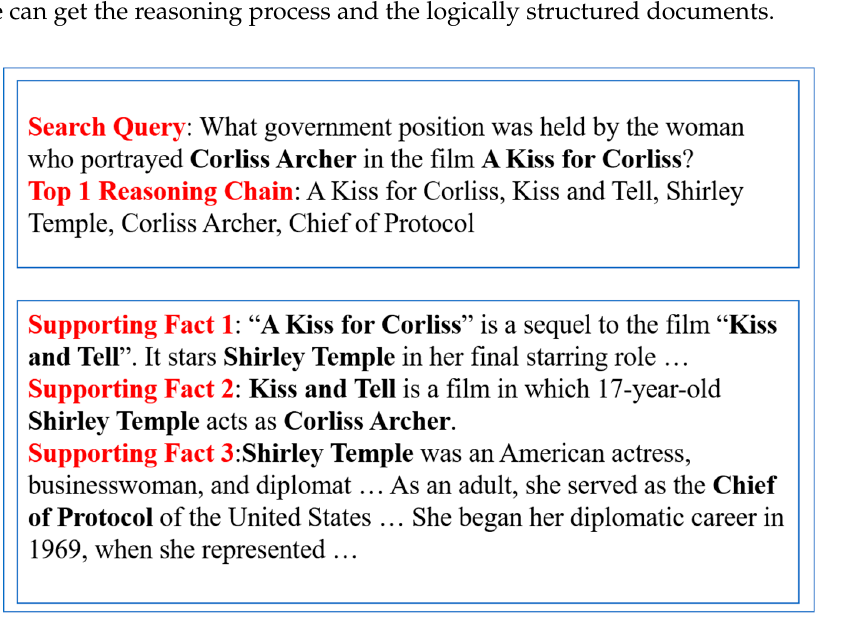
Figure 6. Another case study in the development set. Several documents are given as supporting facts for the search query.